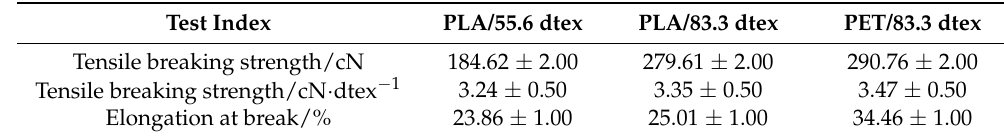
Table 2. Mechanical properties of three kinds of multifilament.